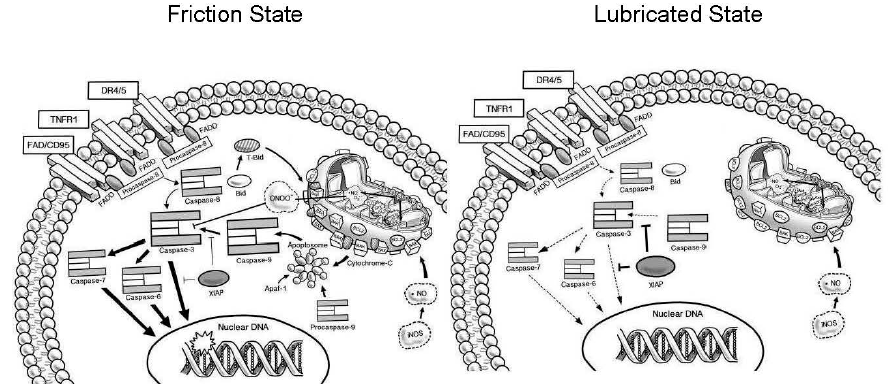
Figure 6. Proposed model of friction-induced mitochondrial dysregulation. A significant increase in the number of chondrocytes that display activation of caspase-3 is caused by friction at the articular cartilage surface from the absence of PRG4. Mitochondrial dysfunction is caused by excessive mechanical strain applied to cartilage tissue and by extension, its embedded chondrocytes. The increase in mitochondrial permeability causes the release of cytochrome C which binds to apoptotic protease activating factor 1 (Apaf-1), resulting in the activation of caspase-9, denoted by bold curved solid arrow, and the caspase-3, 6 and 7 cascade, denoted by bold solid straight arrows, which culminates in intrinsic apoptosis. Levels of Bcl2 are depressed in the high friction state, and unable to counteract Bax and t-Bid, denoted by a bold curved arrow, in promoting mitochondrial membrane permeability. Caspase-3 activation by activated capase-9 is normally inhibited by XIAP in the lubricated state, denoted by the bold blunted solid line, which has lower expression in the friction state resulting in unopposed activation of caspase-3. Although many chondrocytes will show immunohistochemical evidence of caspase-3 activation, these cells do not die and the activation of the intrinsic apoptosis pathway is reversible upon the application of lubricin to the articular surface. Extrinsic apoptosis is not active as friction-induced changes in caspase-8 activity do not occur, and do not initiate the caspase-3, 6 and 7 cascade. Caspase-3 is directly inhibited in the high friction state by peroxynitrite (ONOO ´ ), a product of mitochondrial stress, which causes the nitrosylation of Cys163 in the active cleft of caspase-3, denoted by the blunted line. This inhibitory protein modification serves to arrest the progression of intrinsic apoptosis that would otherwise result in caspase-3, 6 and 7 mediated cleavage of PARP and unapposed DNA-fragmentation caused by